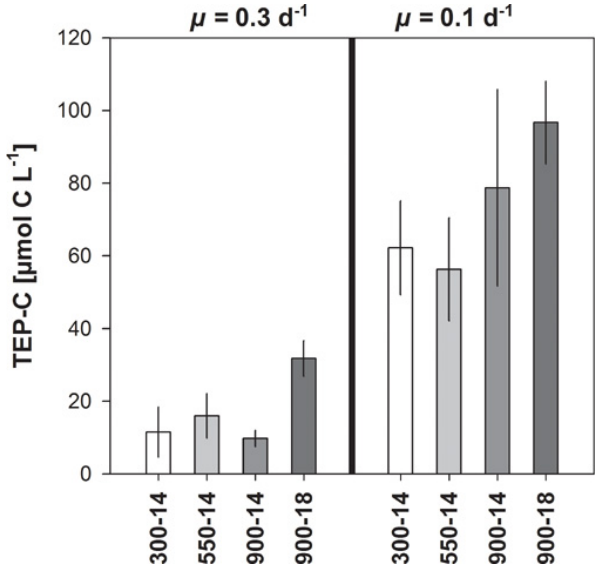
Fig. 6. Correlation between the concentration of dissolved organic carbon (DO 14 C, µ mol C L − 1 , derived from Eq. 1) and the car- bon content of transparent exopolymer particles (TEP-C) (Pear- son Product Moment Correlation; n = 24, r 2 = 0 . 862, p < 0 . 001). Open and closed symbols represent data obtained at µ = 0 . 3d − 1 and µ = 0 . 1d − 1 ,